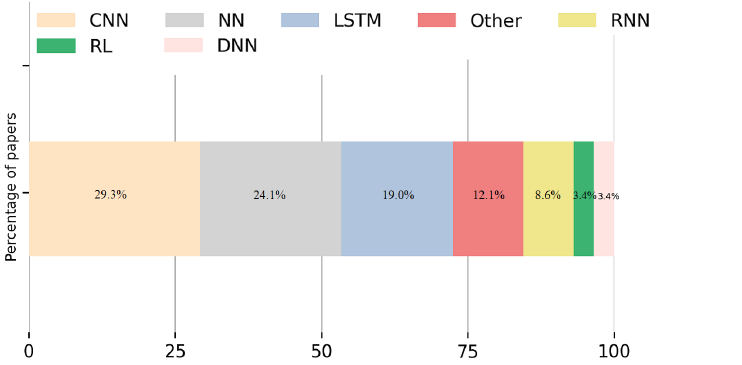
Figure 23. Percentage of papers per DL category of algorithms found in the sample studied. The three most applied DL techniques are CNN, NN and